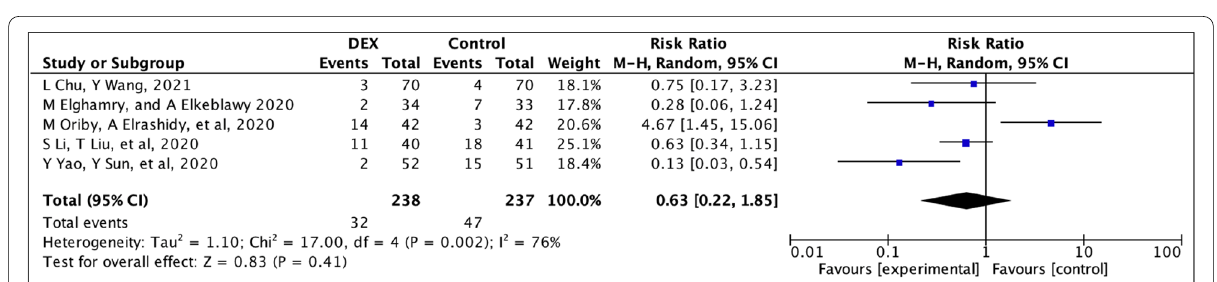
Fig. 6 A forest plot of PONV incidence. Weights are from a random effects analysis. Key: CI, confidence